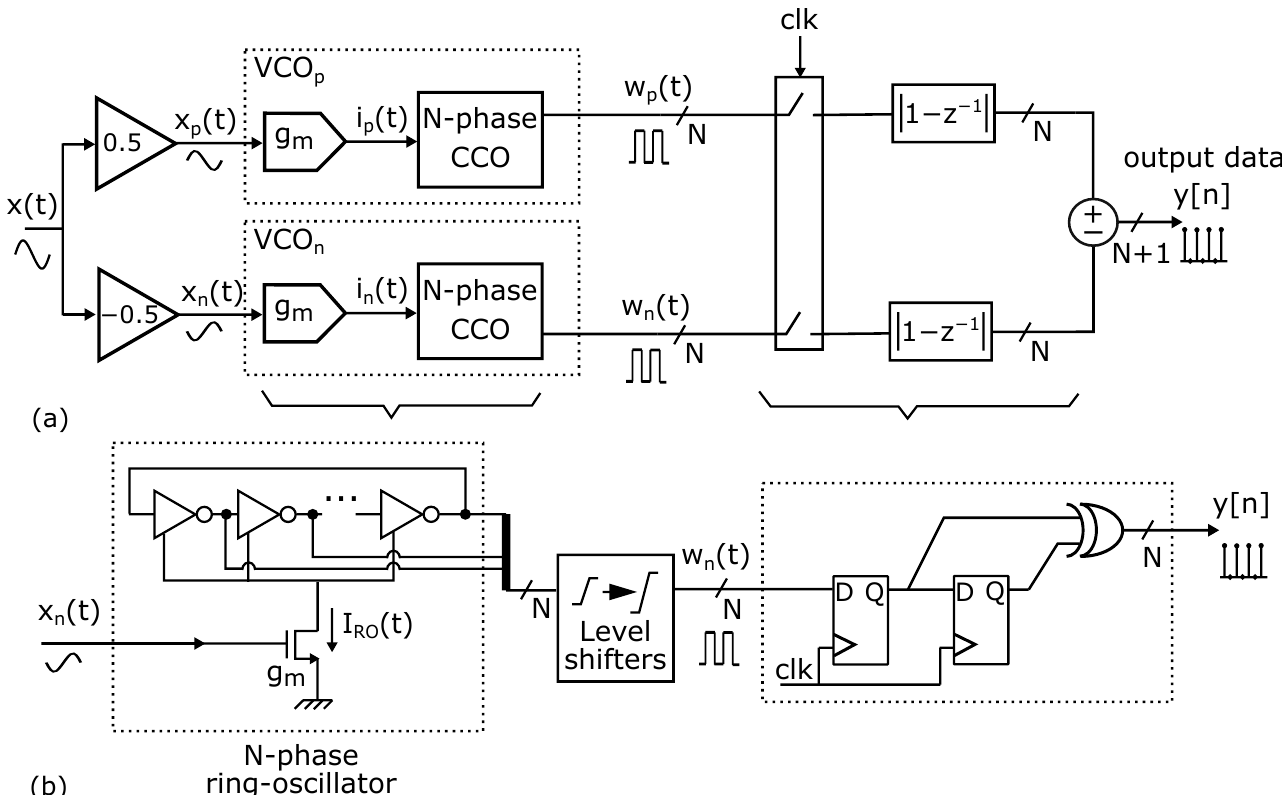
Figure 2. ( a ) Pseudo-differential configuration for an open-loop VCO-based ADC; ( b ) circuit built with an N-phase ring-oscillator, level shifters, flip-flops, and XOR